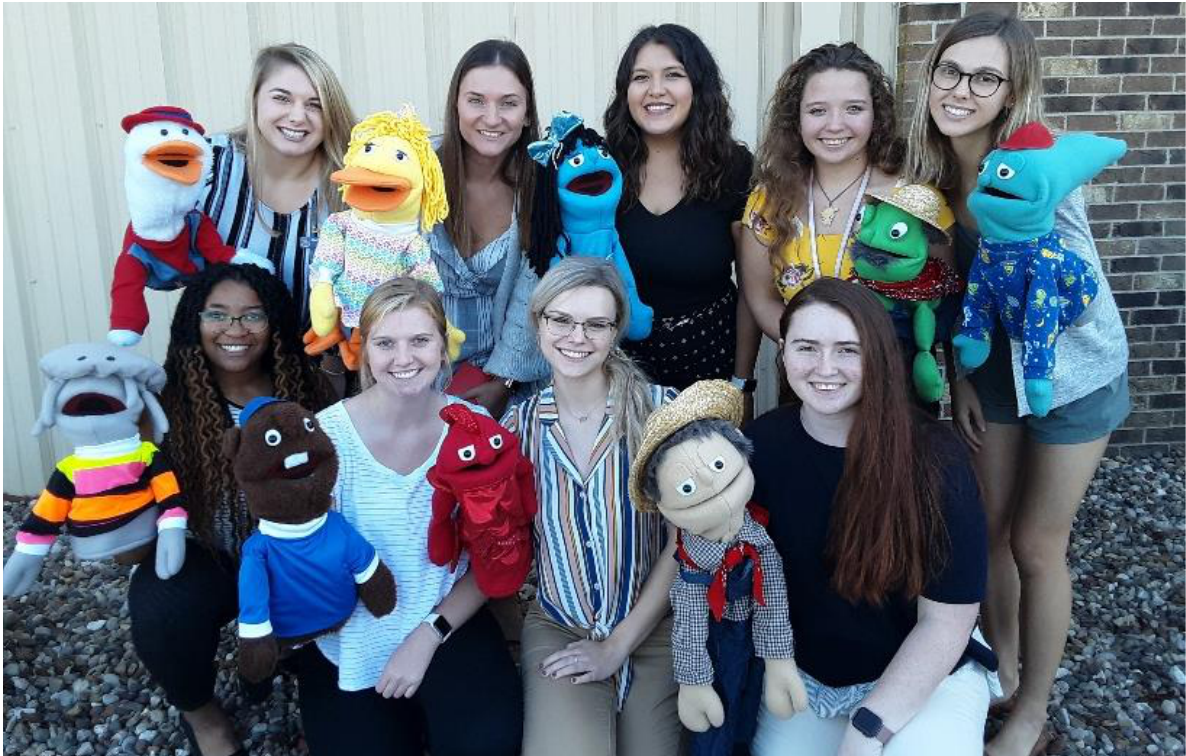
Figure 1. Tobacco Tips Program Instructors Shown With Cast of Puppet Characters